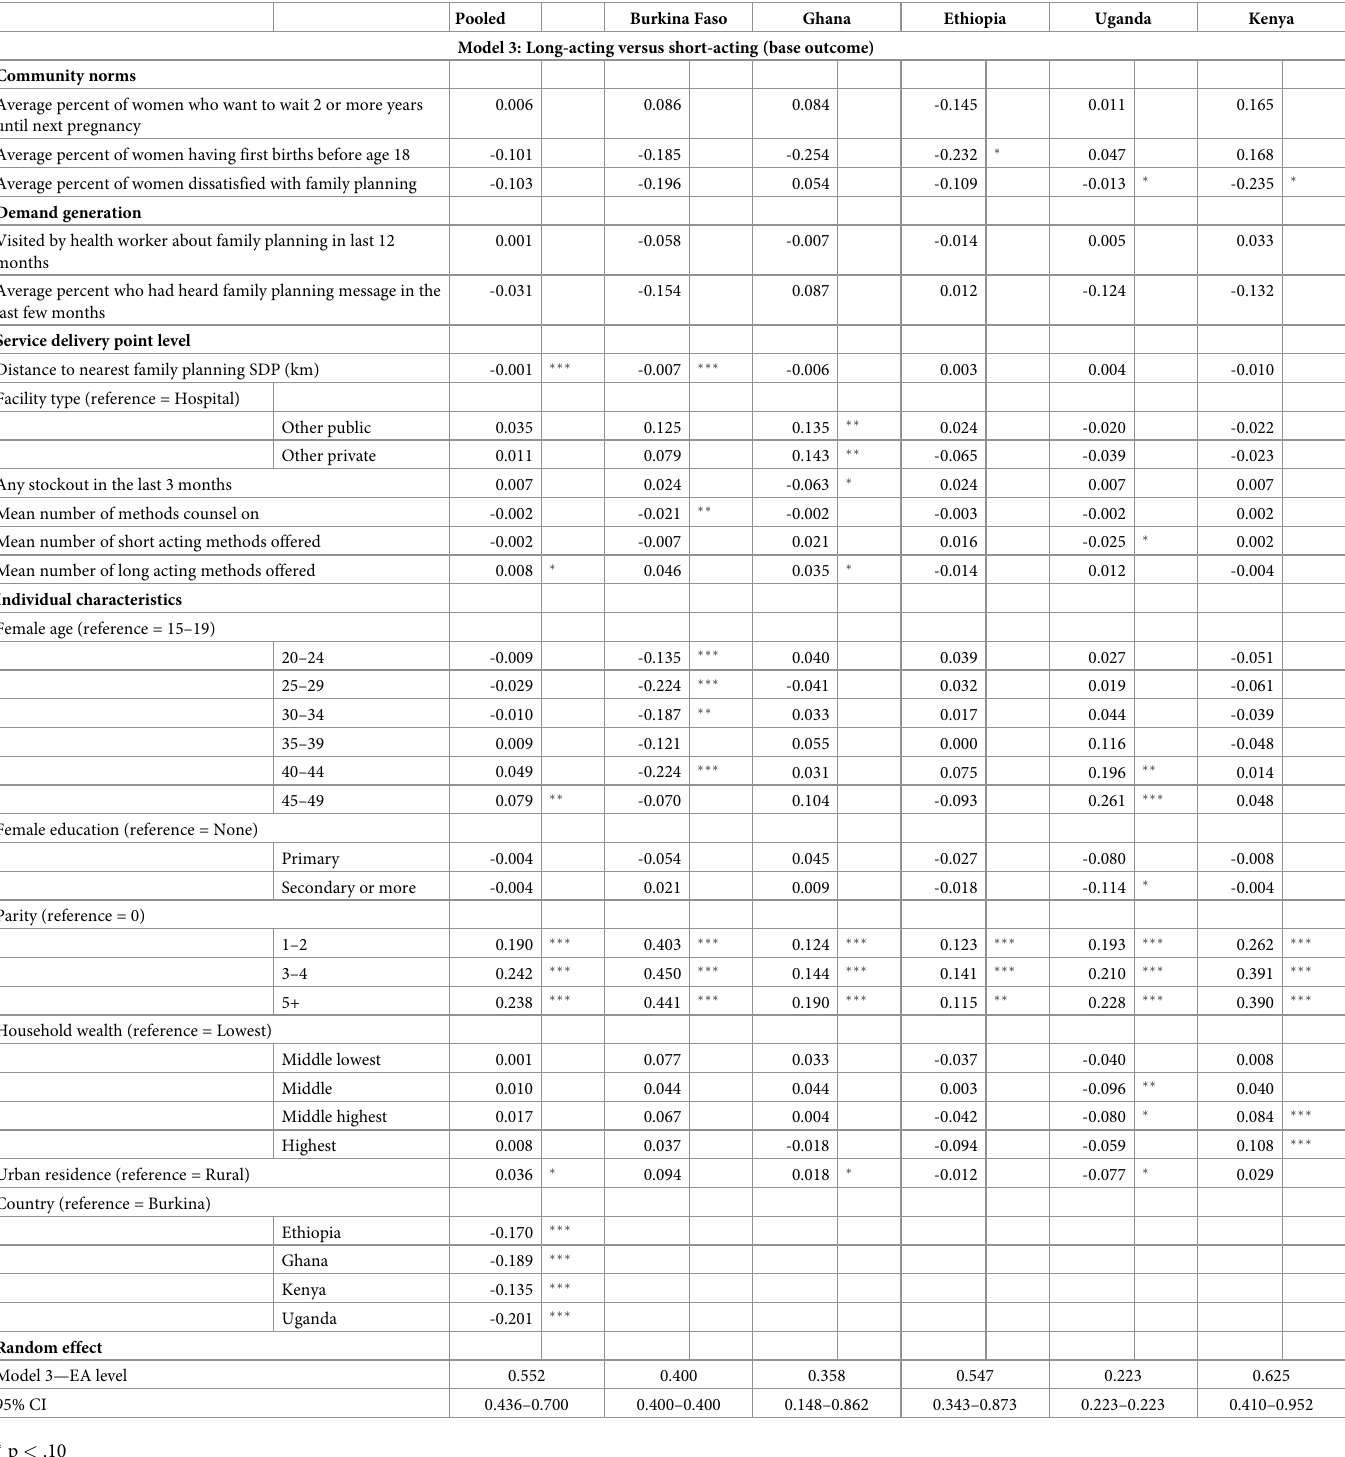
Table 5. Average marginal effects from the multilevel multinomial logistic regression model of individual women’s probability of long-acting contraceptive use rel- ative to short-acting contraceptive use on community, demand generation, and service delivery point variables adjusted for individual level socioeconomic charac- teristics, by country. Pooled Burkina Faso Ghana Ethiopia Uganda Kenya Model 3: Long-acting versus short-acting (base